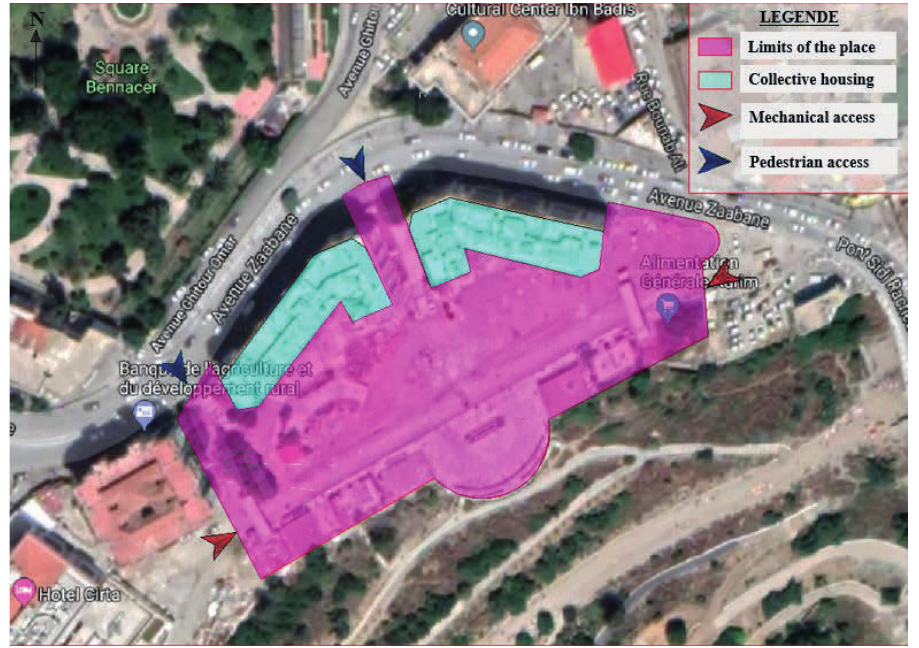
Fig. 7. Location of